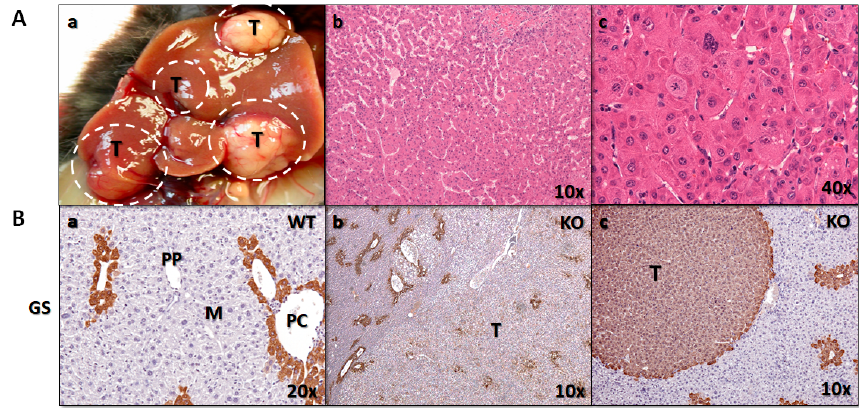
Figure 2. ( A ) Macroscopic and histological presentation of liver tumors. ( a ) Representative gross image of liver tumors in 24M KO mice. ( b ) Representative histologic image of HCC showing architectural abnormalities. ( c ) Higher magnification of ( c ), showing cellular and nuclear polymorphism with brisk mitotic activity. Hematoxylin and Eosin (H&E), original magnification A, B × 100, C × 400. ( B ) Immunohistochemical expression of GS marker of HCC in livers of WTs and KOs. Original magnification, ( a ) × 200, ( b ) × 100, ( c ) × 400. GS, glutamine synthetase; T, tumor; PP,